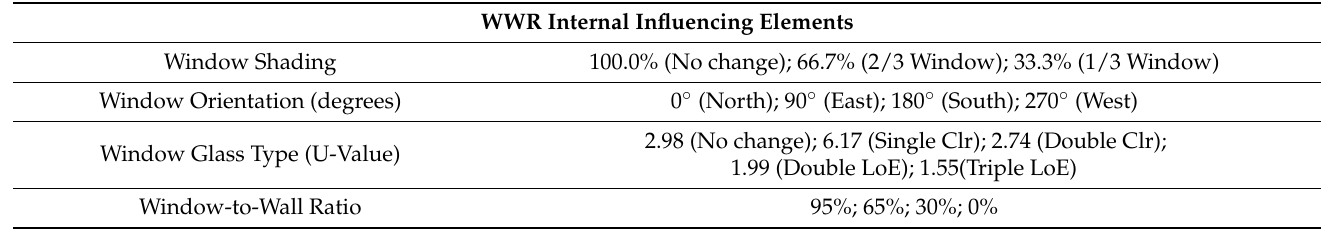
Table 7. Summary of WWR internal influencing